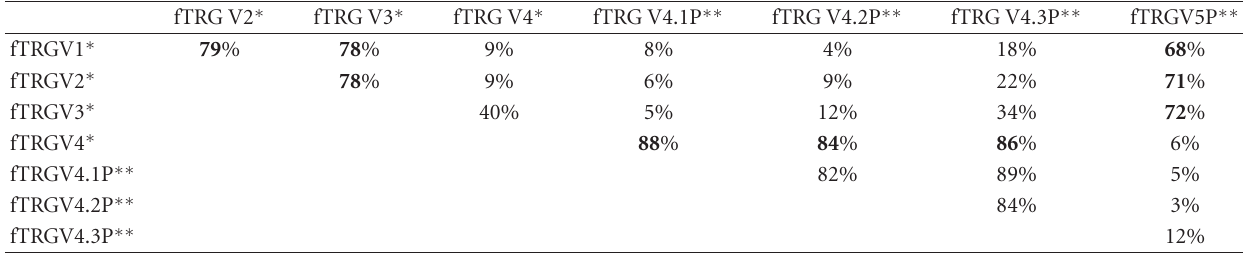
Table 1: Nucleotide homology of feline V-region genes.